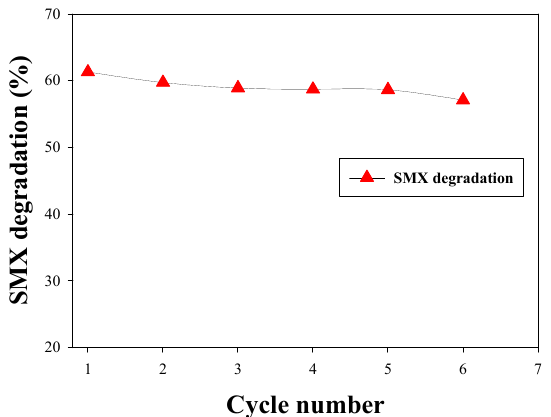
Figure 11. Cyclical degradation of SMX by HNTs-M-chitosan (1%)-GTA- Laccase in the presence of the redox mediator GUA, pH 4.2 at 25 °C.